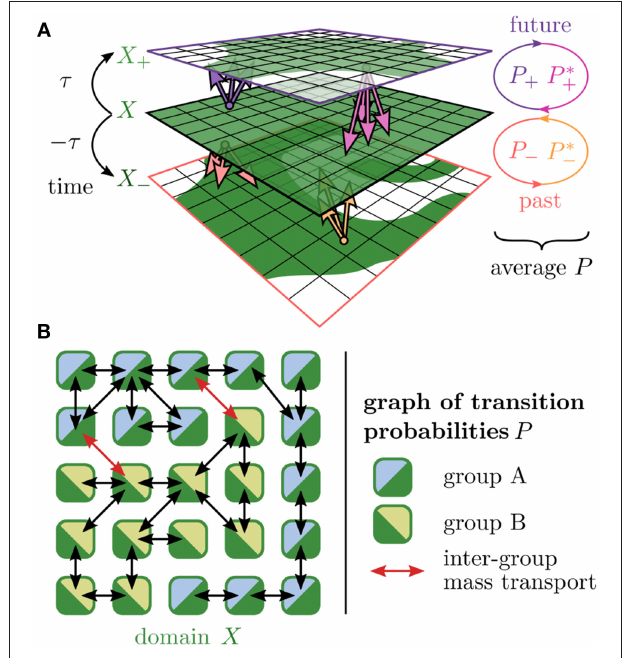
FIGURE 2 | Original time-centralized transfer operator approach. (A) Domain X (green) is transported into future and past with an integration time of τ . The images X + and X − are used to compute matrices of transfer probabilities P + (into future, pink) and P − (into past, orange) between tiles. The combined effects of transport and reversed transport captured by these matrices and their time-reversed counterparts P ∗ + and P ∗ − yield a time-centralized transfer probability matrix P . (B) This matrix P depicts a graph of mass transport that is the basis of an analysis with the aim to separate the tiles X into two groups A (blue) and B (lime) such that the inter-group mass transport (red links) is